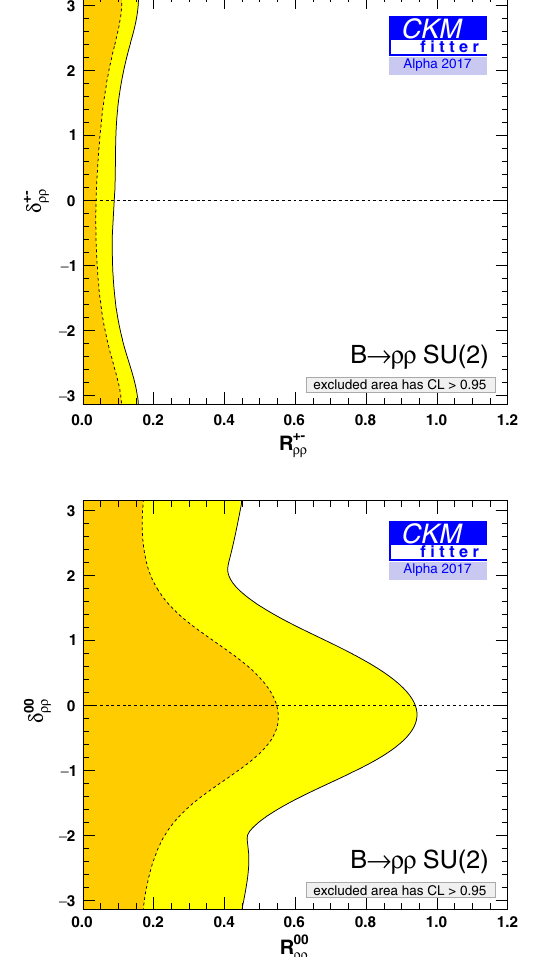
Fig. 21 68% ( dark area ) and 95% CL ( light area ) constraints on the modulus and phase of the penguin-to-tree ratio P ij / T ij = R ij e i δ ij for B 0 → ρ + ρ − ( top ) and B 0 → ρ 0 ρ 0 ( bottom )